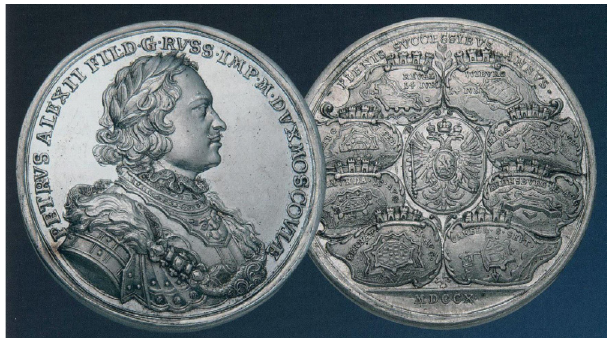
Fig. 2. A medal from 1710 commemorating the capture of Livonia by Peter the Great (P. Krokosz 2017)